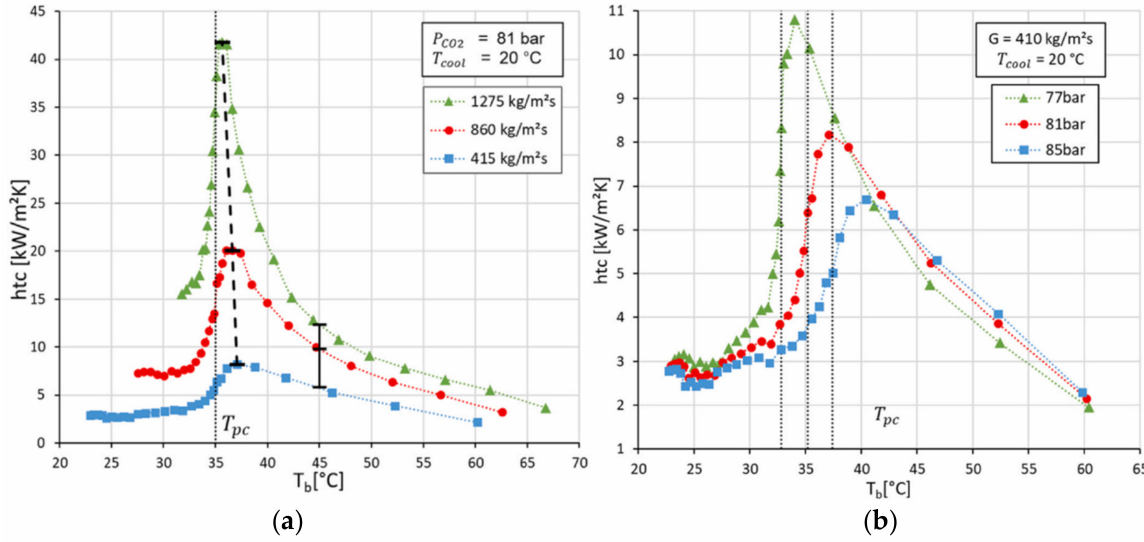
Figure 6. Heat transfer coefficient at different mass fluxes ( a ) and pressures ( b )